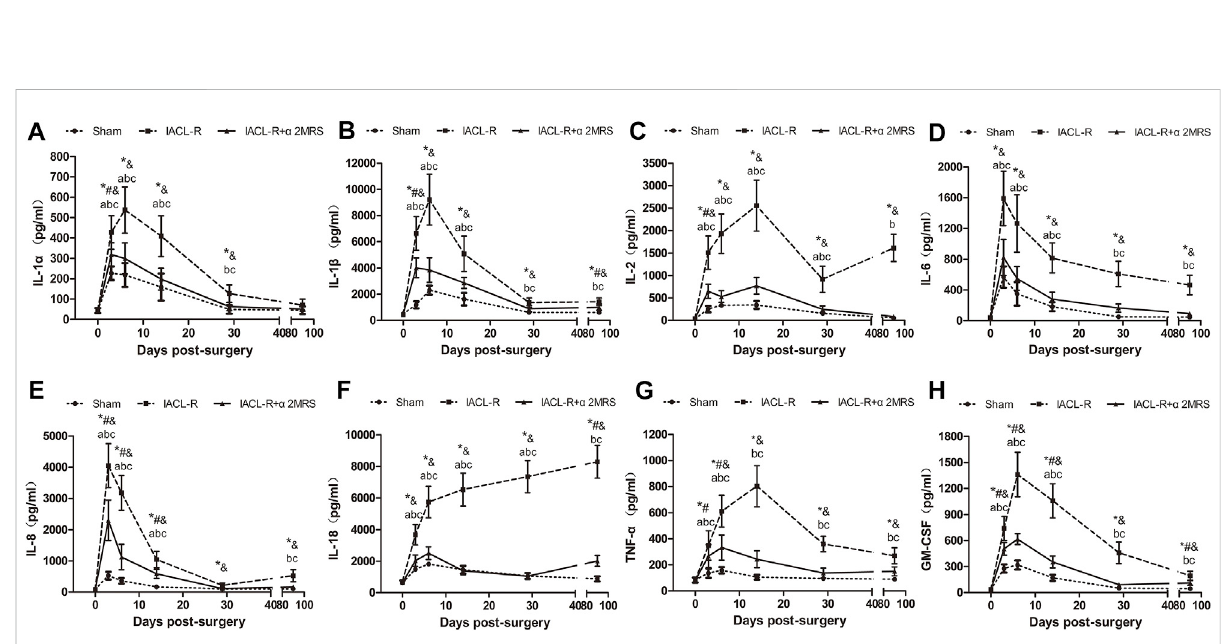
FIGURE 4 Linechartsofin fl ammatoryfactorsinsynovial fl uid. (A) :IL-1 α ; (B) IL-1 β ; (C) IL-2; (D) IL-6; (E) IL-8; (F) IL-18; (G) TNF- α ; (H) GM-CSF.*= p < 0.05, sham group versus IACL-R group at the same time point; # = p < 0.05, sham group versus IACL-R+ α 2MRS group at the same time point; and = p < 0.05,IACL-RgroupversusIACL-R+ α 2MRSgroupatthesametimepoint.a= p < 0.05,preoperative(day0)versuspostoperative(days3,6,14,29,and 90) in the sham group; b = p < 0.05, preoperative (day 0) versus postoperative (days 3, 6, 14, 29, and 90) in the IACL-R group; c = p < 0.05, preoperative (day 0) versus postoperative (days 3, 6, 14, 29, and 90) in the IACL-R+ α 2MRS group. The bars show the mean ± SD (n =